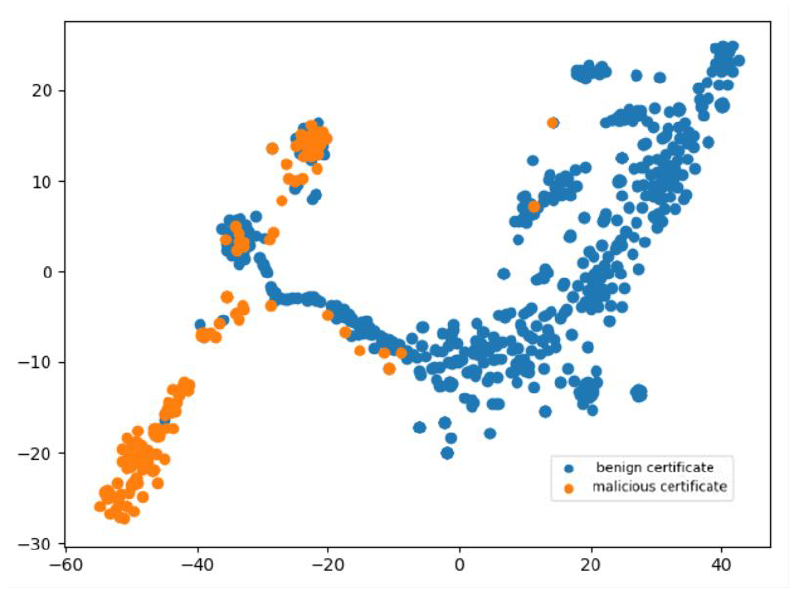
Figure 6. Visual classification of certificate documents by Cert GCN, in which yellow points are malicious certificate nodes and blue points are benign certificate nodes.